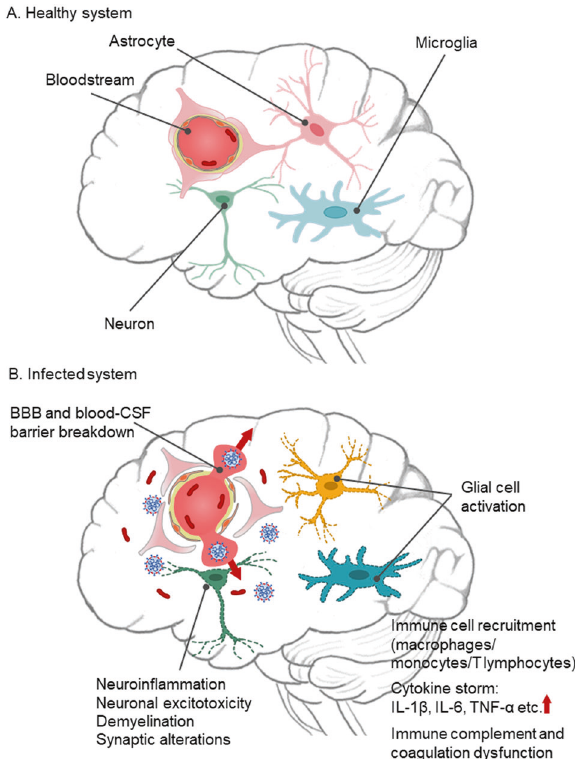
Fig. 2 Schematic illustration of proposed consequences of SARS- CoV-2 neuroinvasion. A In healthy systems, the blood-rain barrier (BBB) prevents most of the macromolecules and neurotoxins in the bloodstream from entering the brain tissues, which is achieved through the components of the neurovascular unit (e.g., endothelial cells, astrocytes). B Growing evidence suggests that SARS-CoV-2 may invade brain tissue. The virus may enter the bloodstream through multiple pathways and infect the neurovascular cells, causing the breakdown of the BBB and blood – cerebrospinal fl uid (CSF) barrier. Their breakdown will further trigger the in fl ammatory responses, including the recruitment of macrophage and T lymphocytes, activation of astrocytes and microglia, cause a vicious cycle of the cytokine storm (production and release of IL-1 β , IL-6, TNF- α , etc.), and disrupt immune complement and coagulation cascades. The infection may also cause immune-mediated demyelination, neuro- nal excitotoxicity, and dysfunction of synaptic plasticity, which ultimately contributes to worsened neurological and neuropsychia- tric symptoms in COVID-19